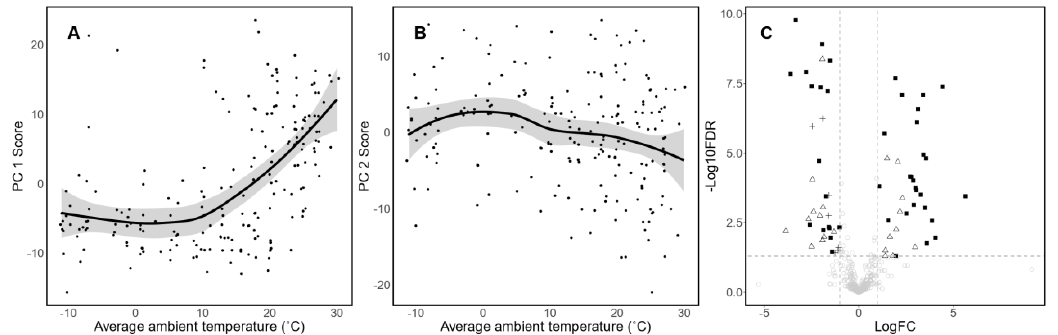
Figure 2. Association between ambient temperature, season, and human milk metabolomic profile. ( A ) Association between average ambient temperature and PC 1 score of each sample collected. Grey area represents se of estimates. PC 1 score was positively associated ( β = 0.34, p = 1.29 × 10 −14 ) with ambient temperature based on multiple linear regression adjusting for infant age, sex, and maternal age. ( B ) Association between average ambient temperature and PC 2 score of each sample collected. Grey area represents se of estimates. PC 2 score was negatively associated ( β = − 0.13, p = 0.002) with ambient temperature based on multiple linear regression adjusting for infant age, sex, and maternal age. ( C ) Volcano plot of differentially expressed metabolites between samples collected in summer and in winter. —metabolites that were not differentially expressed; ∆ —differentially (cid:35) expressed metabolites according to t -test and fold change; +—differentially expressed metabolites which were overlapped with characteristics of PC 2; (cid:4) —differentially expressed metabolites which were overlapped with characteristics of PC